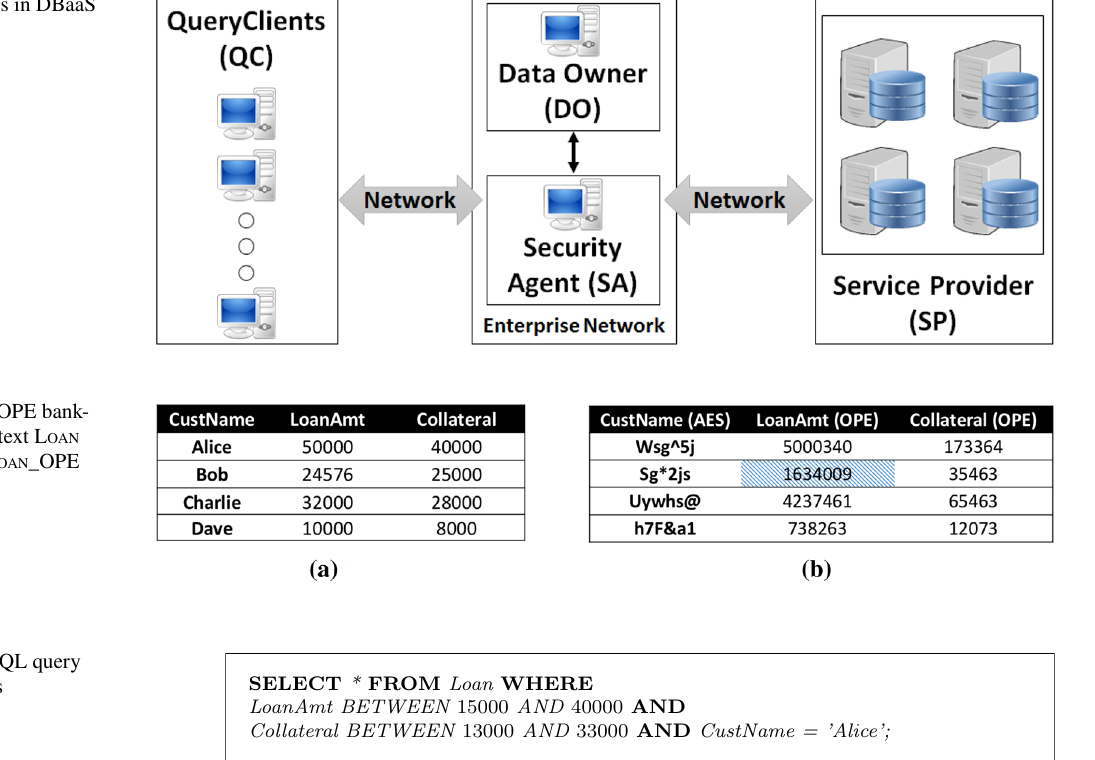
Fig. 1 System entities in DBaaS model